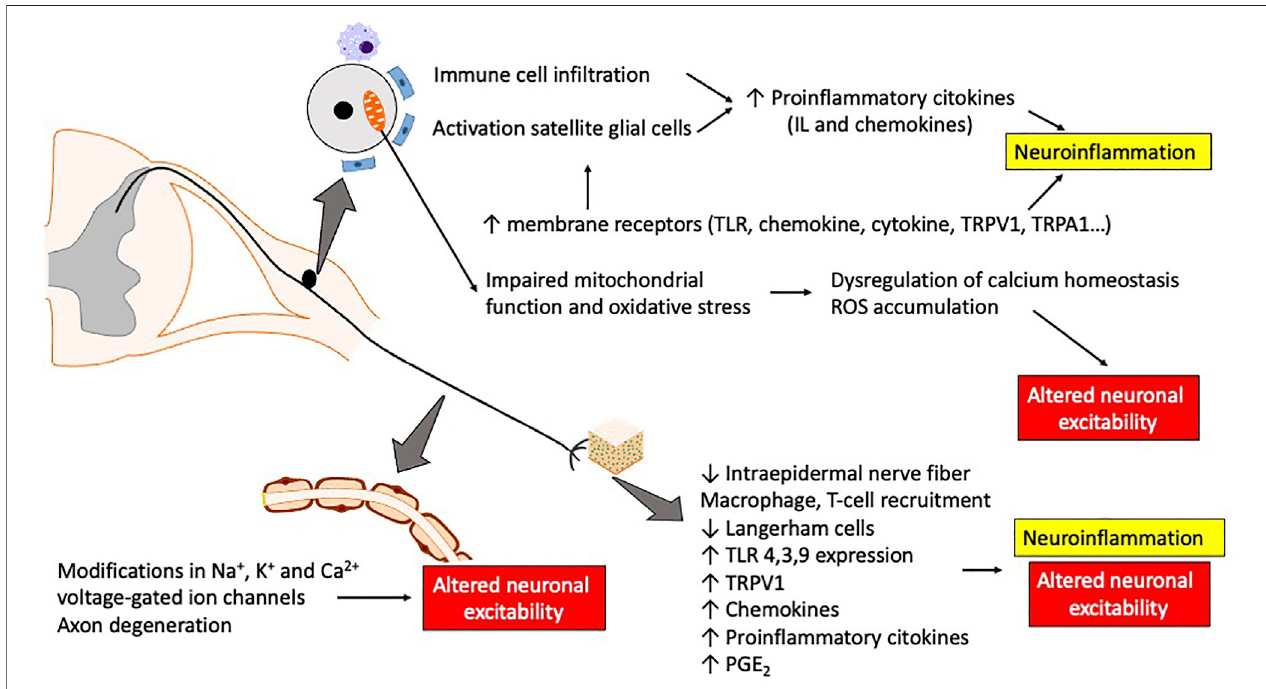
FIGURE 2 | Schematic representation of the main structural alterations, cytokine release and modi fi cations in ion channels and receptors induced by antitumoral drugs which causeneuroin fl ammation and altered neuronal excitability. Abbreviations: IL, interleukins; PGE 2 , prostaglandin E 2 ; ROS, reactive oxygen species; TLR, toll- like receptors; TRP, transient receptor